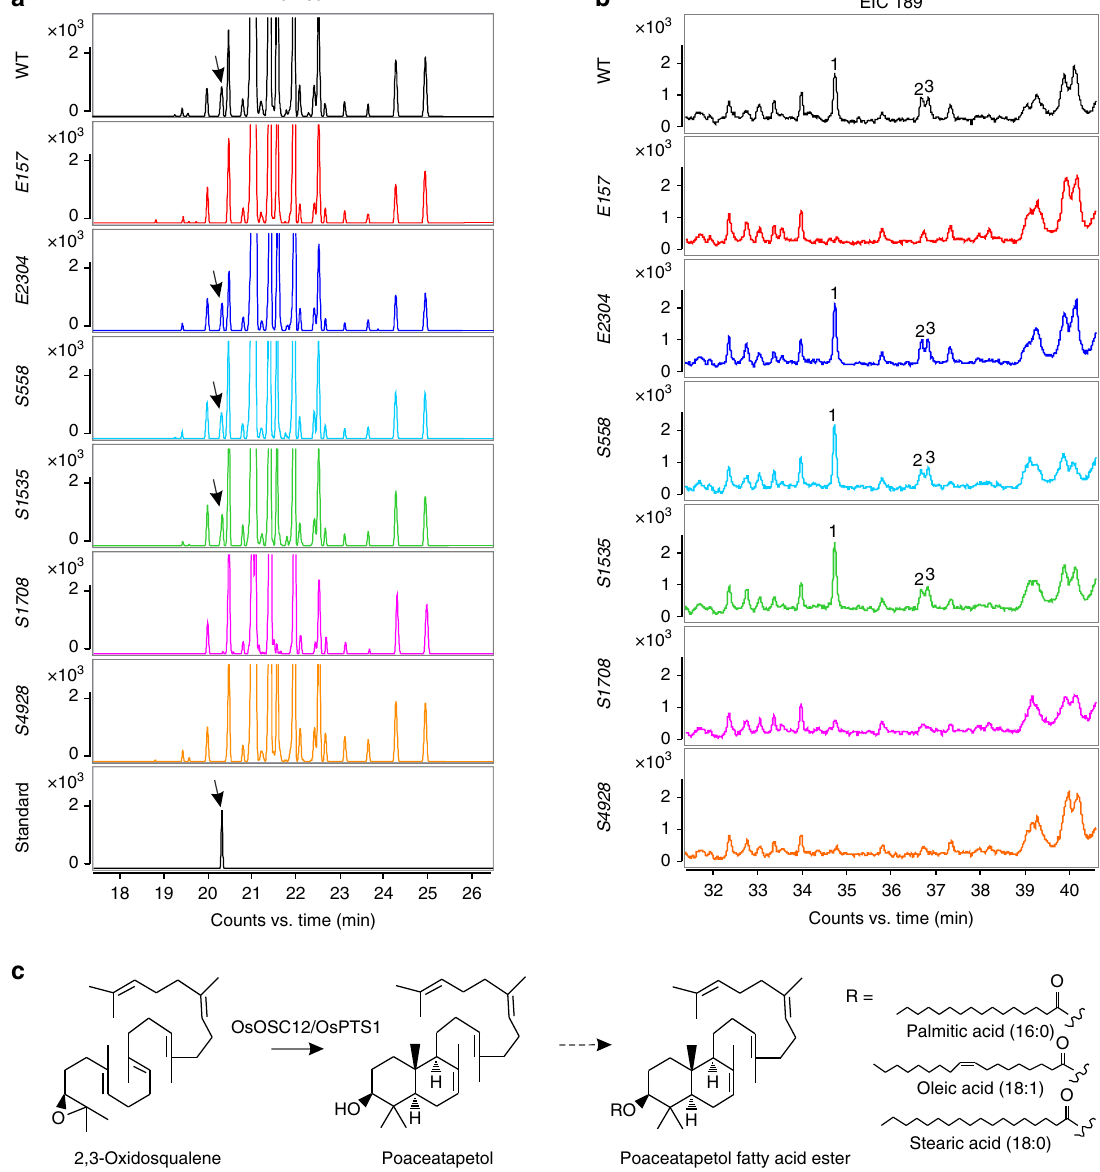
Fig. 5 The OsOSC12 committed triterpene ester pathway. a GC – MS pro fi les of the triterpene alcohol fraction of anther (S12) extracts from OsOSC12 mutant and WT plants. The arrow indicates the peaks present in the WT and the “ silent ” mutants, but absent in the loss-of-function mutants. Standard, puri fi ed poaceatapetol. EIC 189, extracted ion chromatograms at m/z 189. The arrow indicates the poaceatapetol peak. b GC – MS pro fi les of the triterpene esters of anther (S12) extraction from OsOSC12 mutant and WT plants. 1: poaceatapetol palmitic acid (16:0) ester; 2: poaceatapetol oleic acid (18:1) ester; 3: poaceatapetol stearic acid (18:0) ester; EIC 189, extracted ion chromatograms at m/z 189. c The OsOSC12 committed triterpene pathway for biosynthesis of poaceatapetol